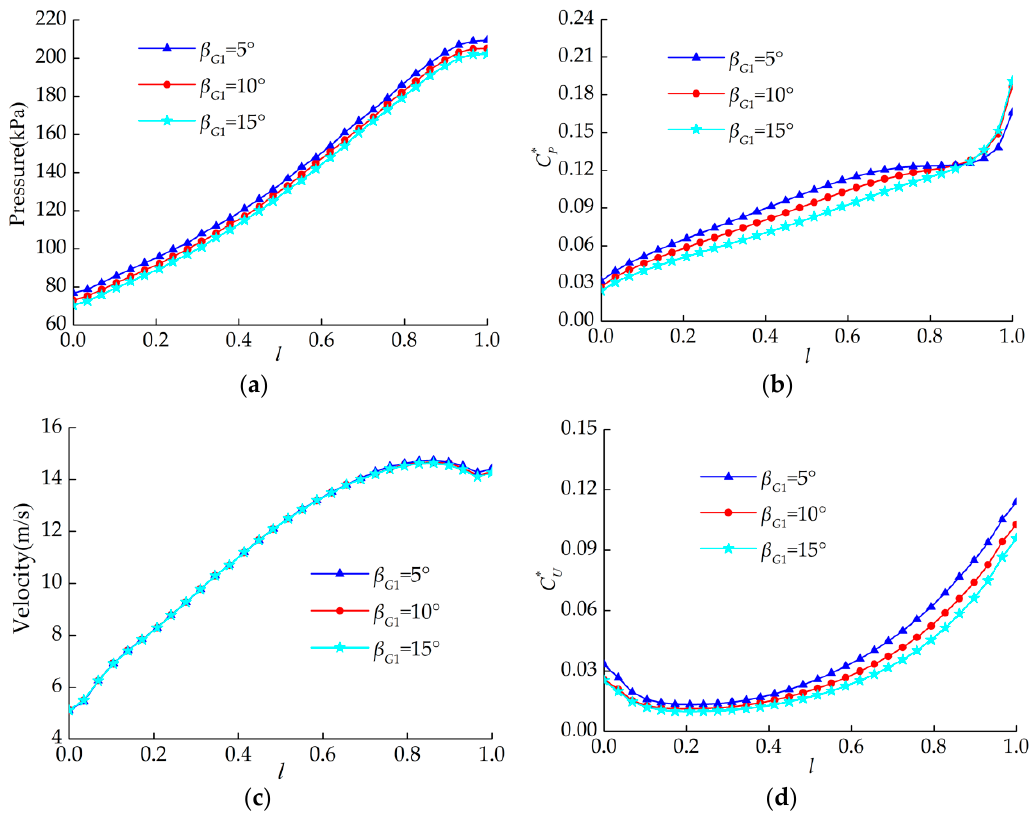
Figure 18. The time-average and the fluctuation intensity curves of pressure and velocity on the blade